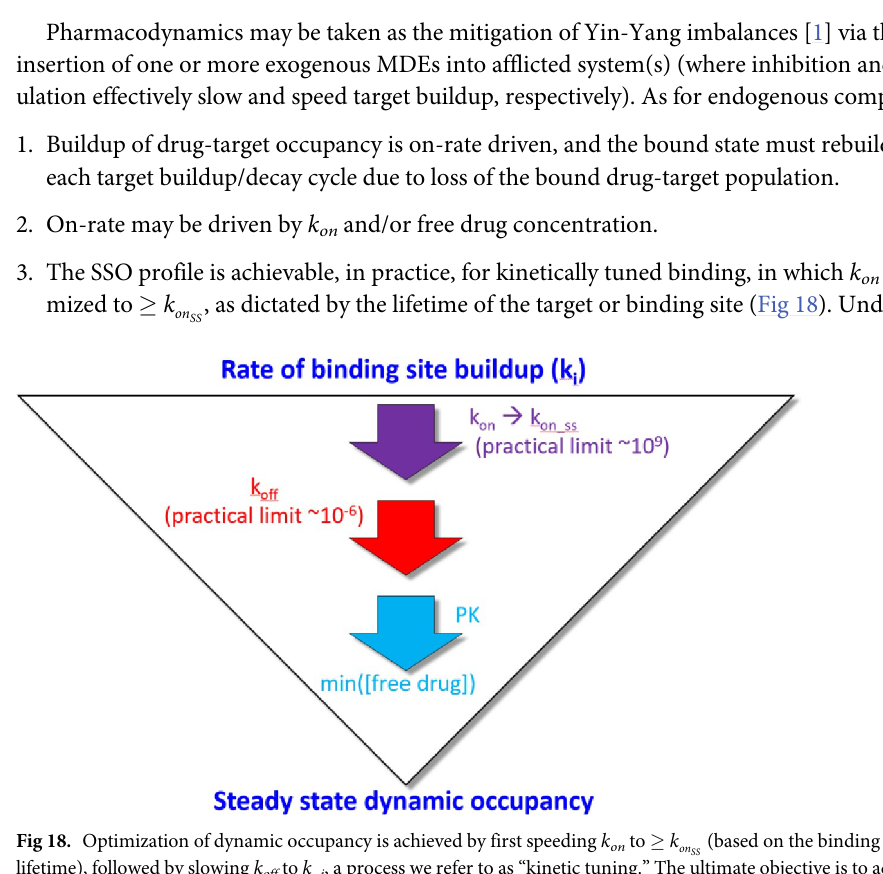
(based on the binding site on SS